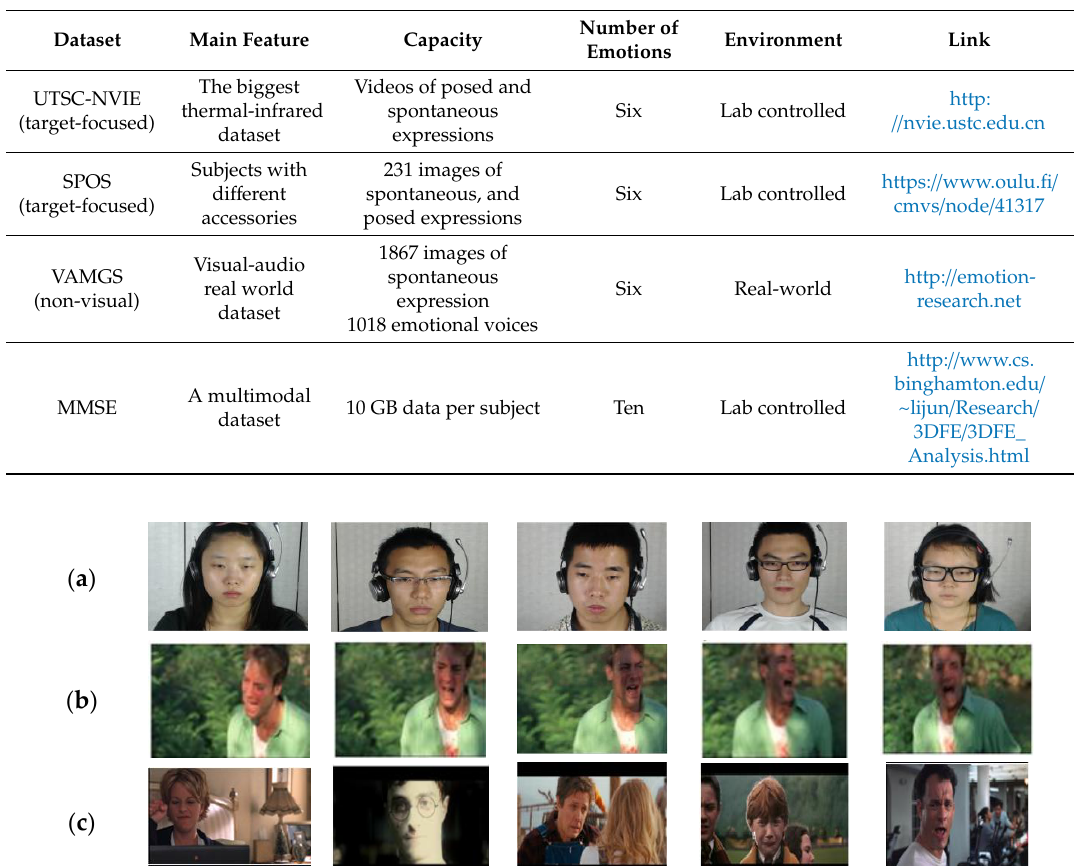
Table 7. The non-visual, target-focused, and multimodal datasets.